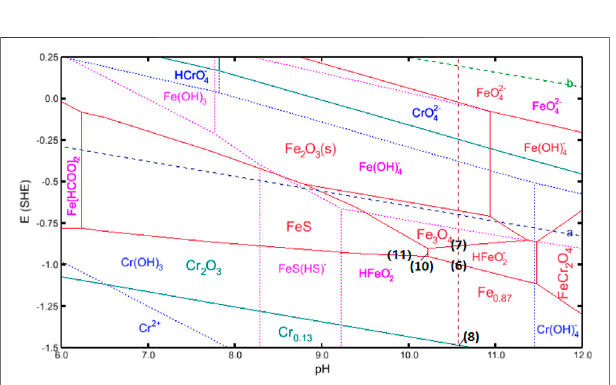
FIGURE 10 | Pourbaix diagram for S13Cr SS under the formate condition with the presence of sul fi de at 180 ° C.